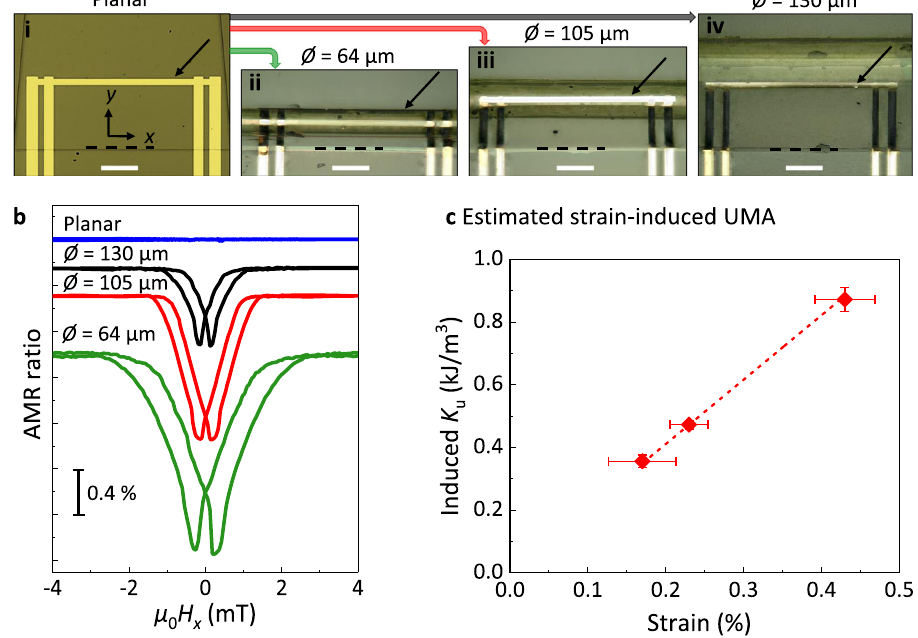
Fig. 4 Estimation of curvature/strain-induced azimuthal uniaxial magnetic anisotropy using electrical (AMR) signal. a - i Optical image of the planar magnetic stripe with contact wires fabricated on top of the polymeric platform. a - ii , iii , iv Optical images of magnetic stripe after rolling down the polymeric platform with different diameters. Scale bar, 100 µm. Depending on the diameter of the tube, the magnetic stripe may be displaced from the tube ’ s dome as indicated by the blue arrows. The stripe in the case of a - ii is hidden under the polymeric tube. The red dashed lines in the images show the position from the bottom where the sacri fi cial layer starts in the planar polymeric platform. b AMR hysteresis measured for rolled stripes of different curvatures. c Estimated azimuthal uniaxial magnetic anisotropy, derived from the measured AMR signal vs. strain in the magnetic stripes. The error bars along the x - and y -axis represent the least count errors resulting from the measurement of bilayer (PI/Ni 78 Fe 22 ) thicknesses, the radius of curvature, and AMR hysteresis measurements,